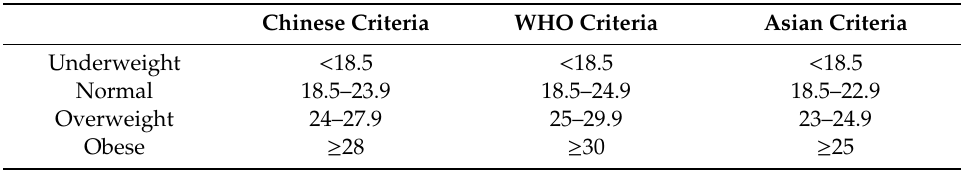
Table 1. BMI according to WHO, Asian and Chinese